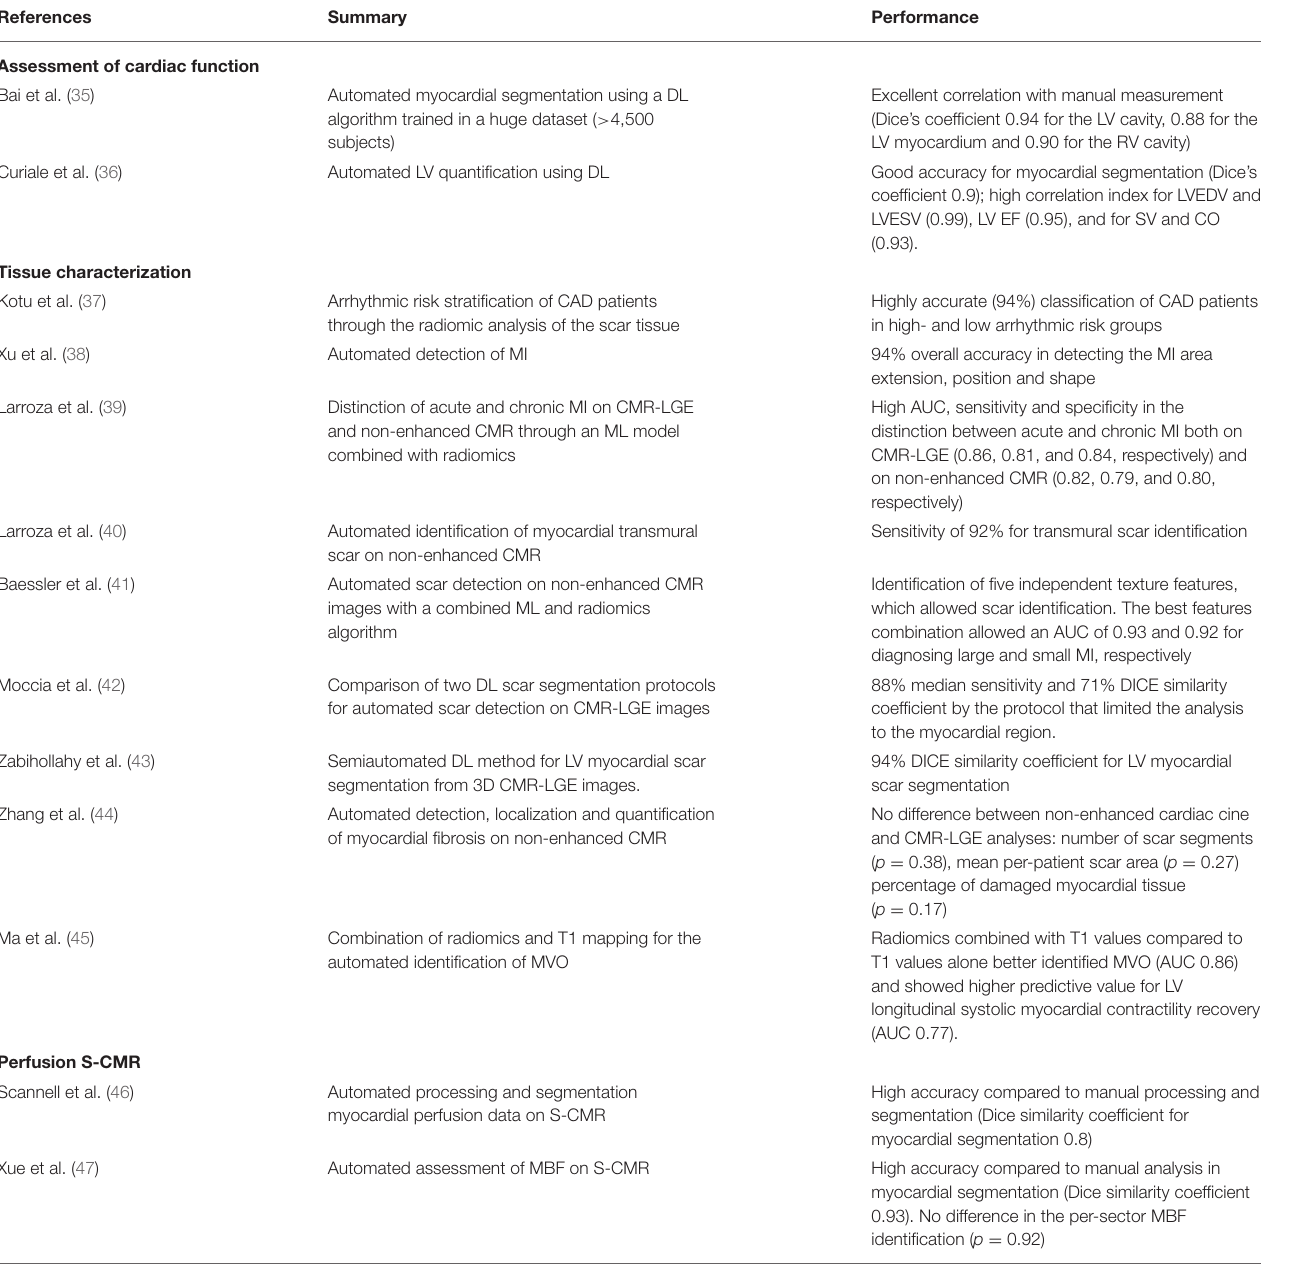
TABLE 3 | Main AI applications to stress cardiac magnetic resonance